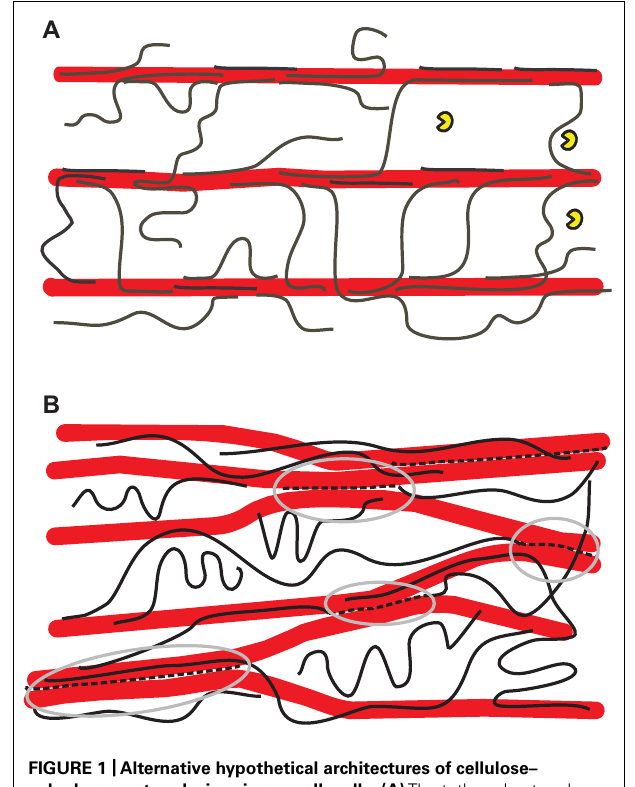
FIGURE 1 |Alternative hypothetical architectures of cellulose– xyloglucan networks in primary cell walls. (A) The tethered network model in which xyloglucans (black lines) fully coat the surfaces of cellulose microfibrils (larger red rods) and additionally span the 20–40 nm gap between adjacent cellulose microfibrils as load-bearing tethers.The distance between microfibrils is large enough to permit penetration of a xyloglucanase-specific endoglucanase (yellow “Pacman” symbols) of the type used by Park and Cosgrove (2012a).This model is based a variety of results (Scheller and Ulvskov, 2010; Hayashi and Kaida, 2011) but is still hypothetical and recent work is at odds with it. In this model, the primary means of cell wall expansion is by cutting the xyloglucan tethers or by destabilizing the xyloglucan–cellulose interaction, resulting in wall stress relaxation and yielding.The directionality of growth depends on the net orientation of cellulose microfibrils (Baskin, 2005; Kerstens etal., 2001). (B) A revised architecture based on the enzyme/biomechanics analysis of Park and Cosgrove (2012a), in which the load-bearing xyloglucan (broken black lines highlighted by gray ellipses) is a minor fraction of the total xyloglucan and is trapped between microfibrils, so it is not accessible to xyloglucan-specific endoglucanase. By this arrangement the xyloglucan glues microfibrils into a network of microfibril bundles which serve to protect it from lytic action by xyloglucan-specific endoglucanases as well as xyloglucan endotransglycosylase/hydrolase.The gray circles demark the limited region that bear the static tensile forces generated by turgor pressure. An arrangement as shown here could account for the lack of wall loosening caused by xyloglucan endotransglycosylase/hydrolases (Saladie etal., 2006; Maris etal., 2009; Miedes etal.,